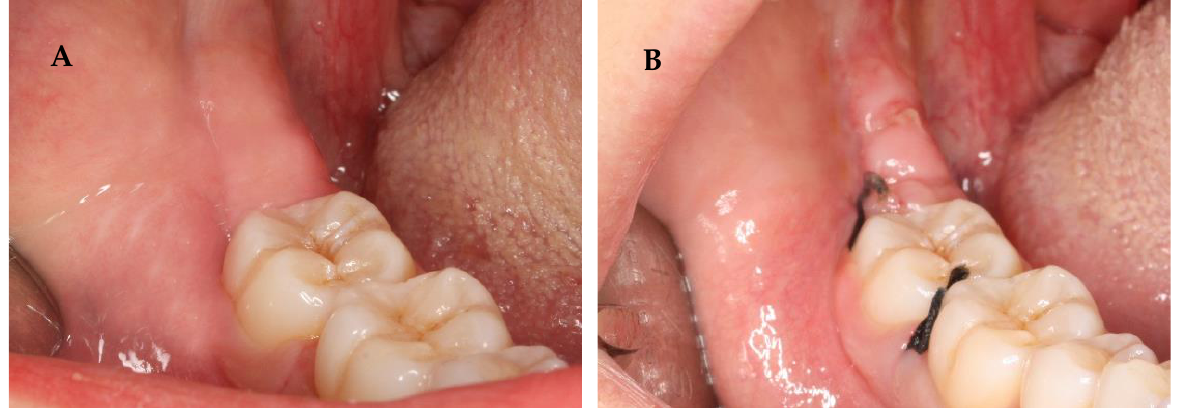
Figure 3. In these images, we can observe the preoperative ( A ) and postoperative ( B )